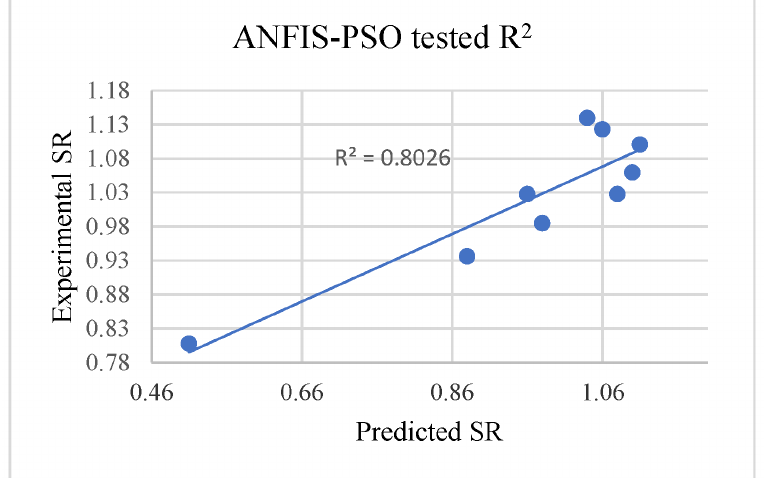
Figure 17. ANFIS-PSO trained regression line .